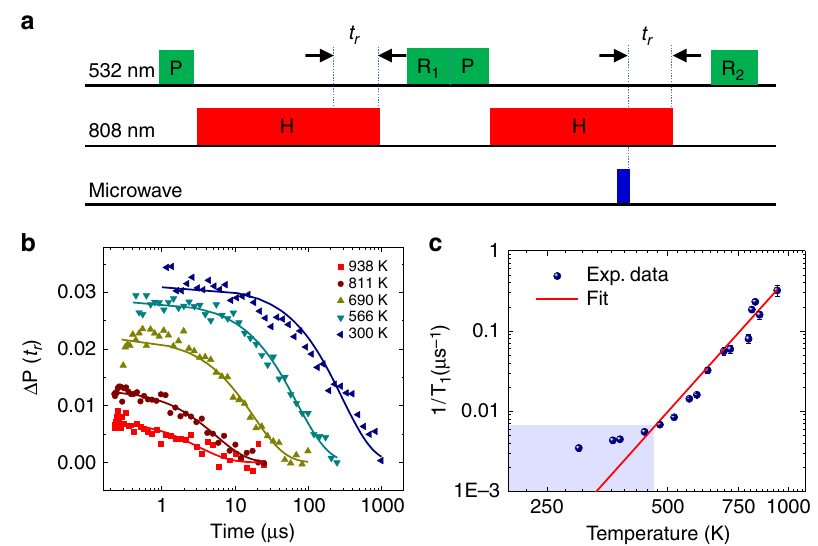
Fig. 3 Spin relaxation of nitrogen-vacancy (NV) centers in a nanodiamond (ND) at high temperatures. a Pulse sequence. After spin polarization by the short green laser pulse at low temperature, the ND is heated to a high stationary temperature by an NIR pulse (5 μ s). The ND is maintained at that temperature for t r with the NIR laser kept on, and then after a fi xed period of cooling (3 μ s) the NV center spins are read out. To eliminate the fl uorescence changes that are not related to spin states, the fl uorescence difference between the m s = 0 and m s = − 1 states are taken as the signal, with a microwave π pulse applied in the latter case. b Spin-dependent fl uorescence as a function of relaxation time, measured for the NV center spins of an ND (NDa2 in Fig. 2c) at different temperatures. c Spin relaxation rate (1/ T 1 ) as a function of temperature. The solid blue circles are experimental data. The red line is the power-law fi tting ¼ AT n ) in the high temperature regime with A = 8 × 10 − 12 s − 1 K − n and n = 5.6 ± 0.5. At lower temperature (shadowed region), the relaxation rate ( T (cid:3) 1 1 saturates. Error bars corresponding to the fi tting errors